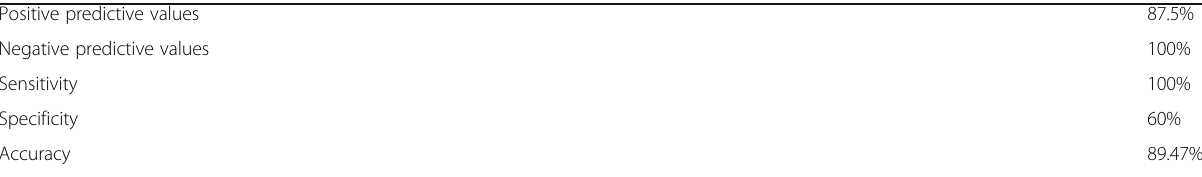
Table 9 Accuracy and positive and negative predictive values of resectability of MDCT in correlation with surgical outcomes Positive predictive